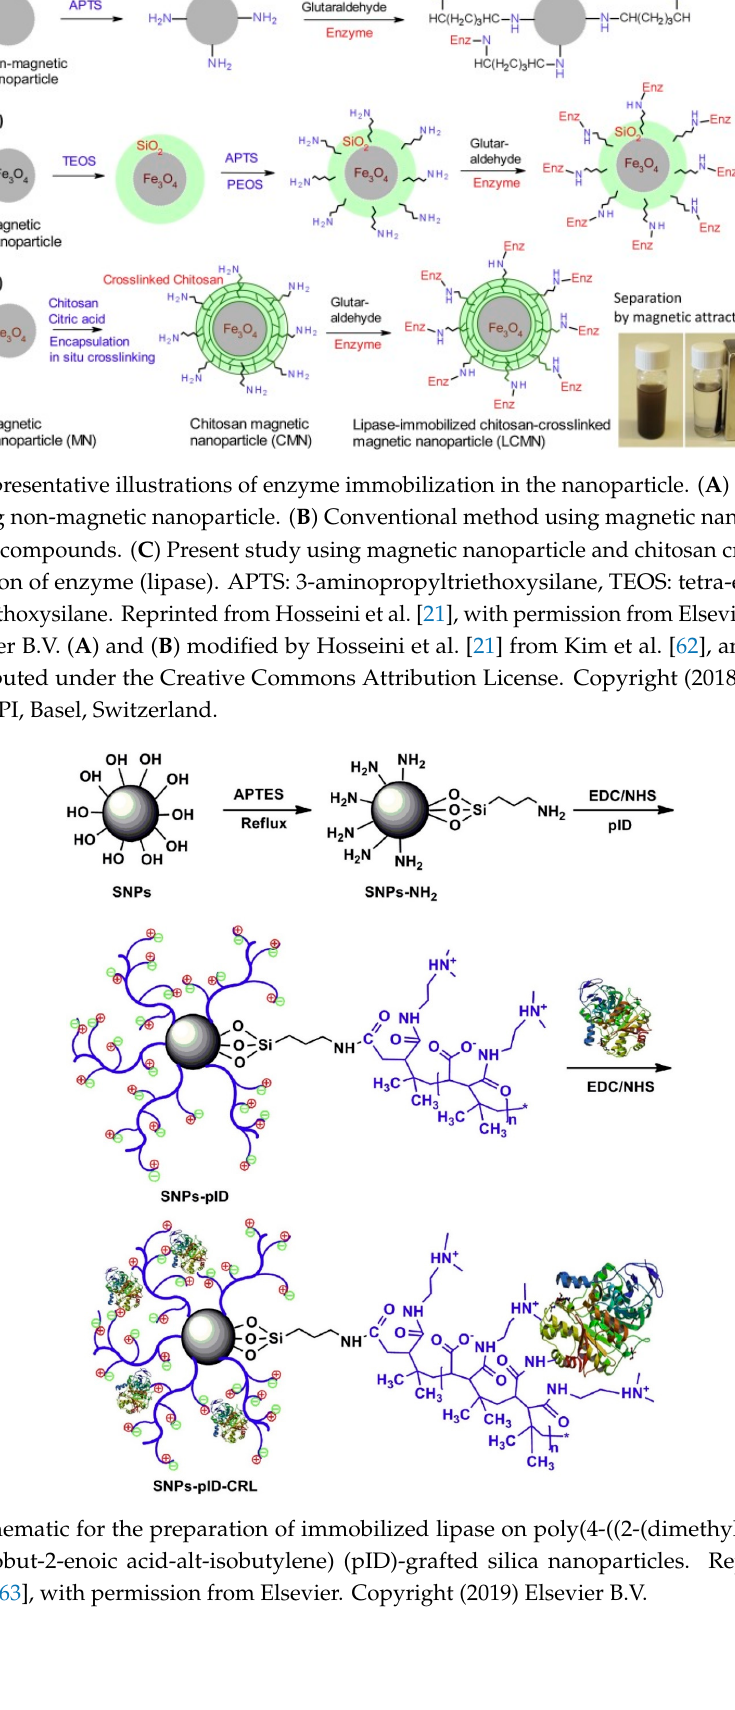
Figure 8. Immobilization of lipase on ionic liquid (IL) modified magnetic chitosan (MCS) composites using graphene oxide (GO) as shell coating. Reprinted from Suo et al. [24], with permission from American Chemical Society. Copyright (2019) American Chemical Society.